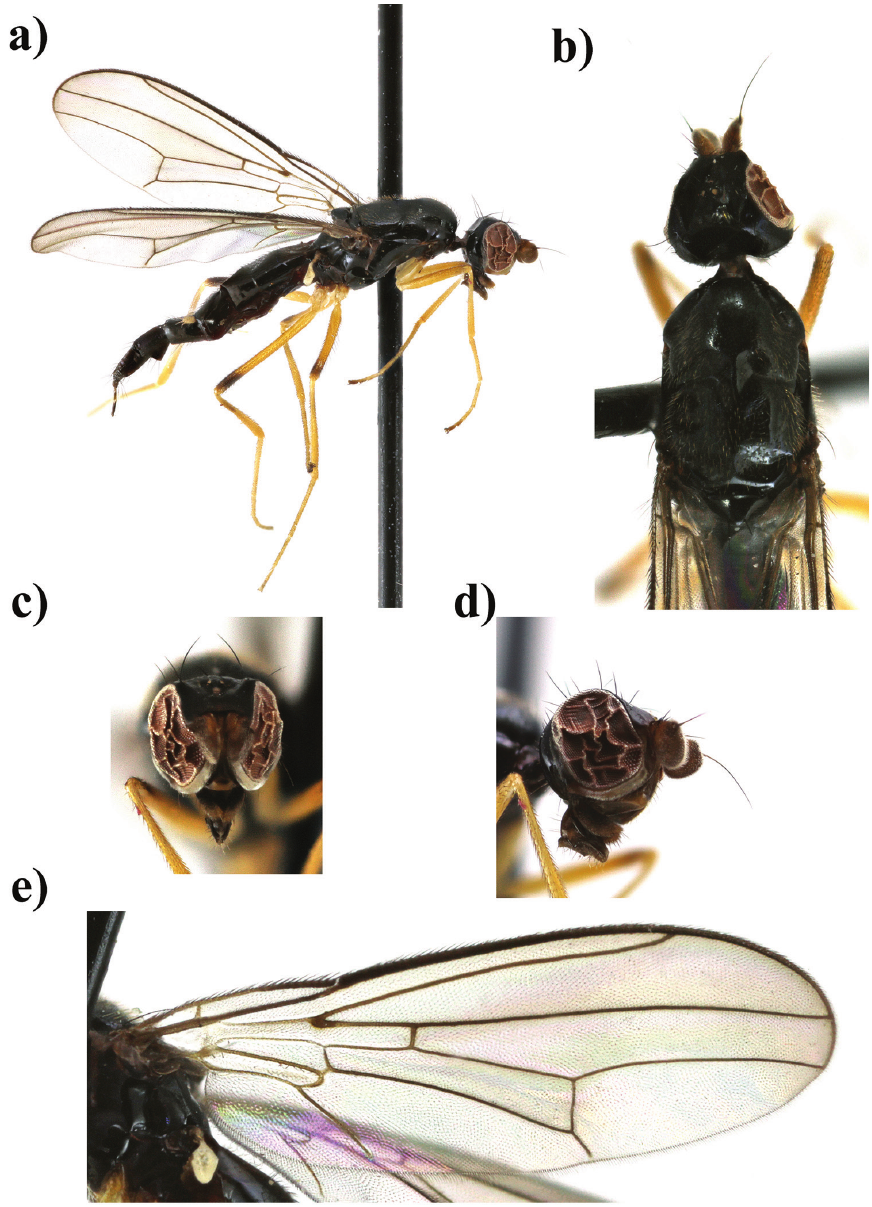
Figure 3. Strongylophthalmyia dichroa sp. n. a habitus, lateral view b head and thorax, dorsal view c head, anterior view d head, lateral view e basisternum f